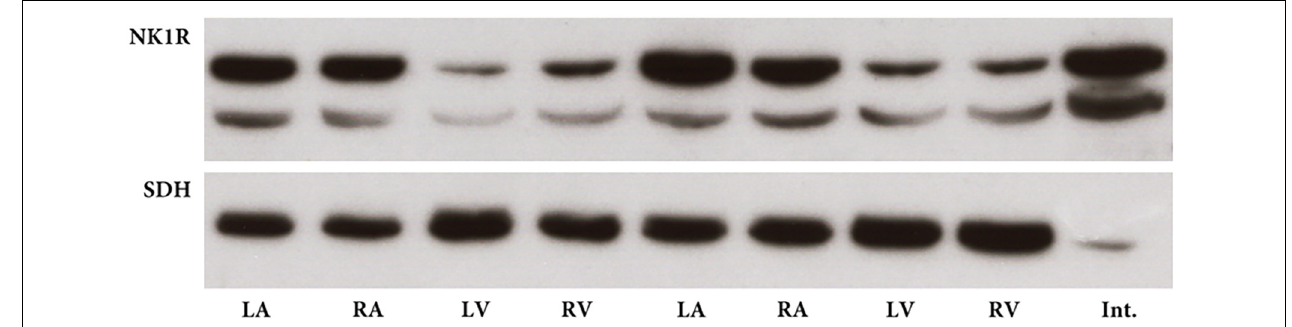
FIGURE 2 | Western blot for NK1 receptor (NK1R) in heart compartments of two rats. NK1R immunoreactive band with expected molecular mass is distinctly present in all heart compartments, left atrium (LA), right atrium (RA), left ventricle (LV), and right ventricle (RV). Sample from intestine (Int.) serves as positive control. Succinate dehydrogenase A (SDH) immunoreactive bands with expected molecular mass demonstrate the presence of approximately similar amount of protein in each sample from heart compartments.